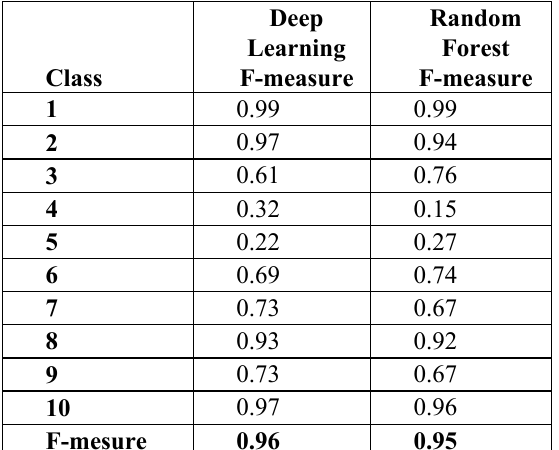
Figure 2: Matrix Confusion of Deep Learning Classification